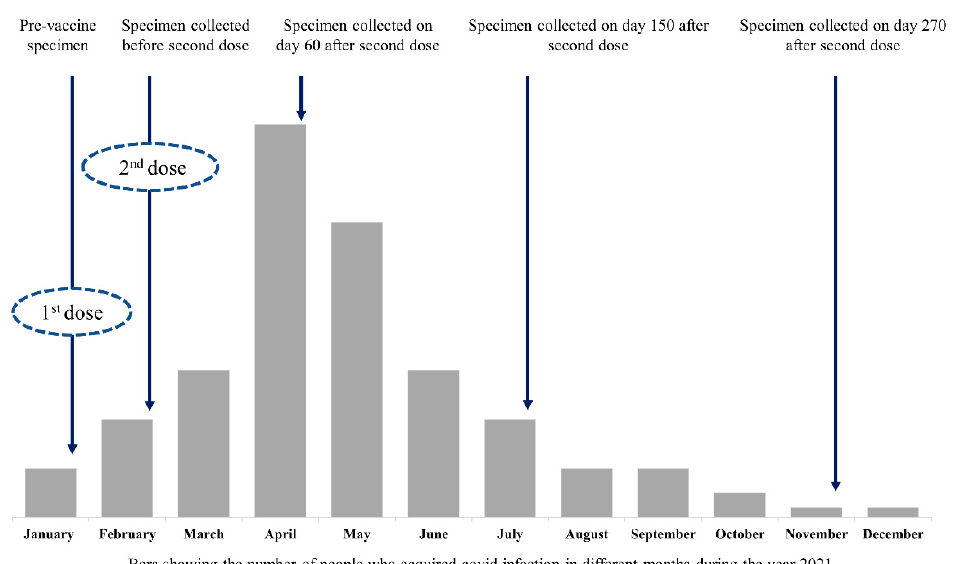
Figure 1. Temporal pattern of the Covid pandemic in the city, time of vaccination and time of blood specimen collection over the period of study.